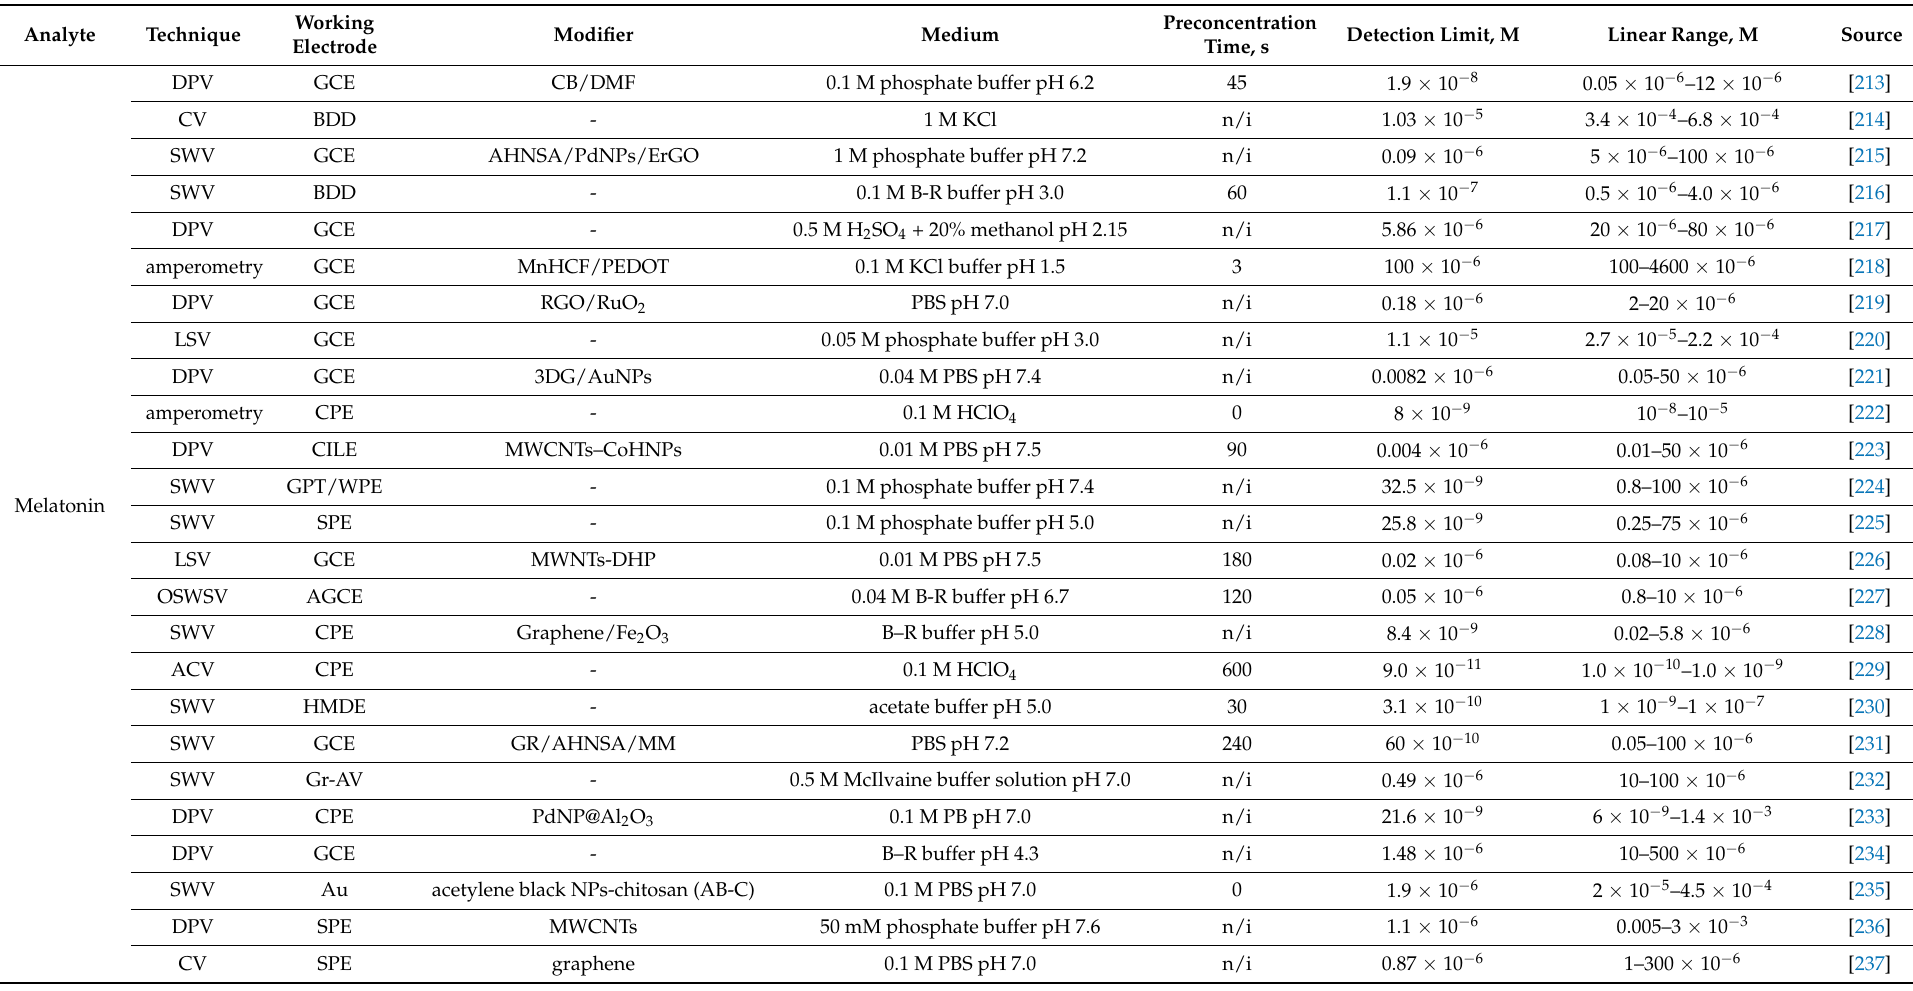
Table 4. Electrochemical methods of pineal gland hormones